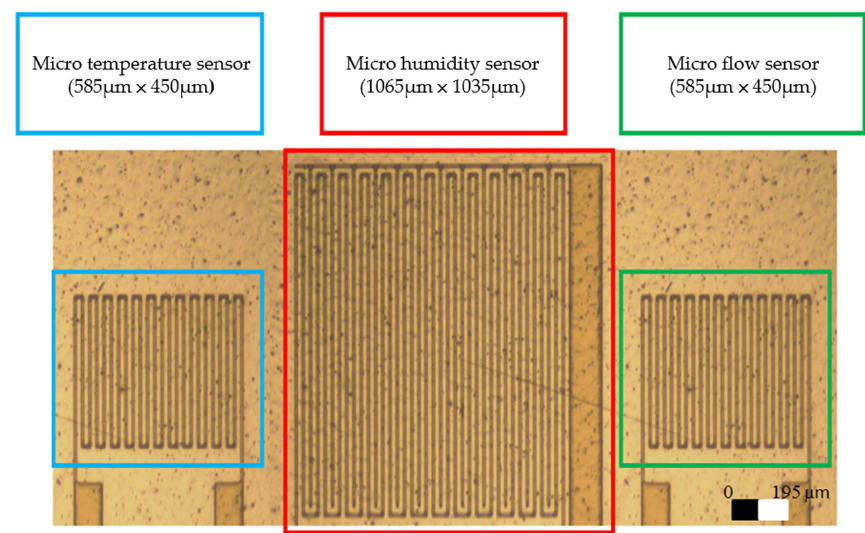
Figure 2. Image of the flexible three-in-one microsensor under the optical microscope.